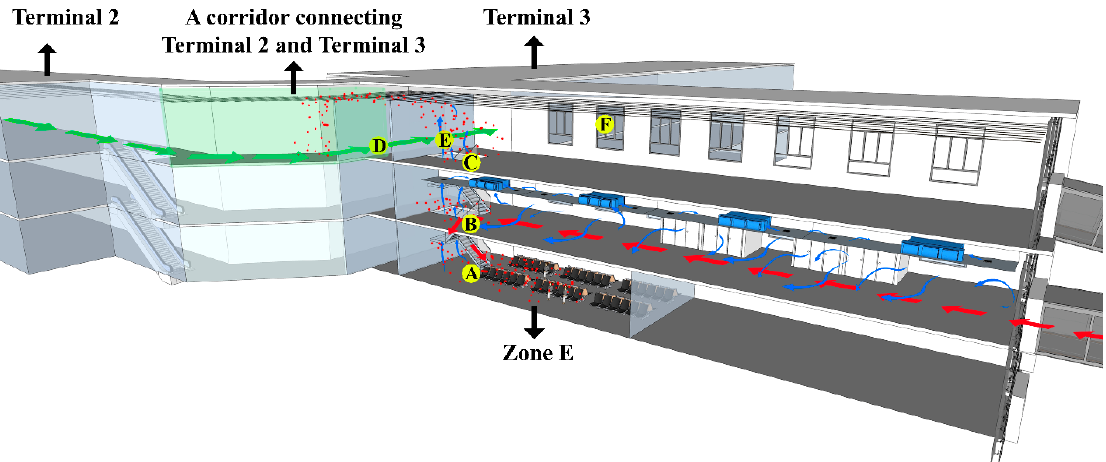
Figure 1. The schematic diagram of architectural composition, airflow layout and walking routes of passengers of the international arrival area of Xi’an Xianyang International Airport and the simulation of viral aerosol diffusion. A: Location of simulating positive cases respiration to generate virus aerosol and monitoring particle concentration changes and environmental factors changes; B–F: Monitoring and sampling points set at the different floors of the international arrival area, the Terminal 2–Terminal 3 corridor and the Terminal 3 hall. Note: represents walking routes of case a and b who were diagnosed as positive COVID-19 cases. represents walking routes of inbound international flight passengers after getting off the flight. represents direction of airflow. ▪ Simulated viral aerosols.